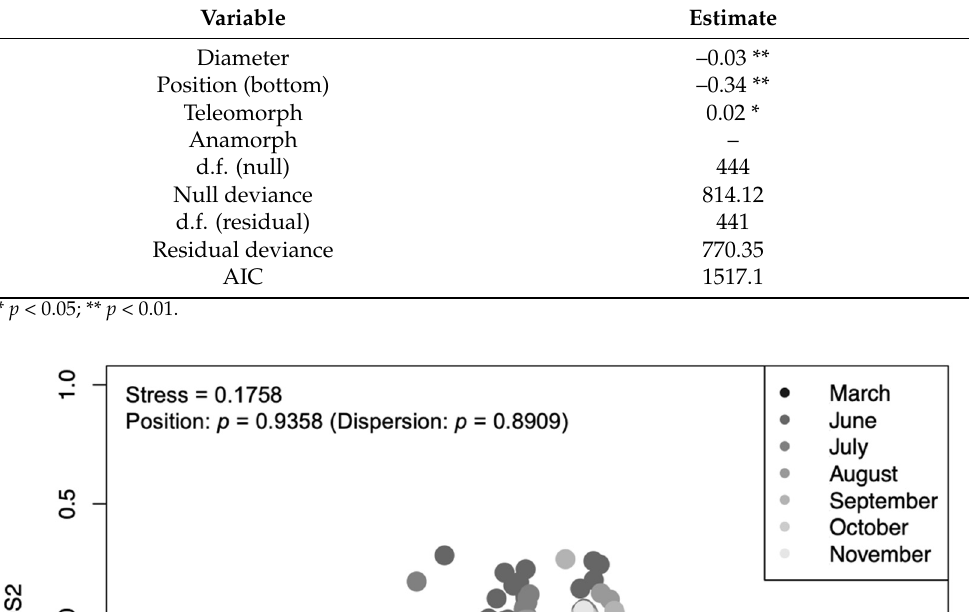
Table 1. GLM results showing associations with insect species richness and log variables.